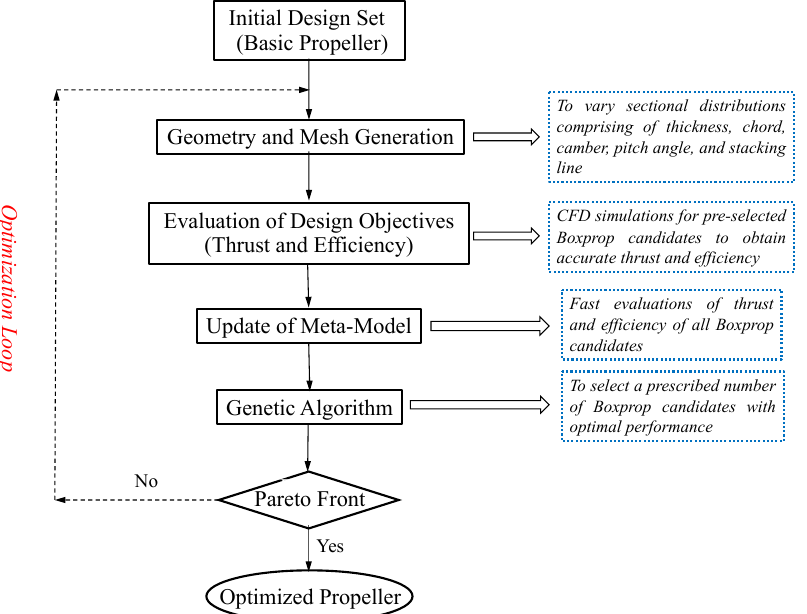
Figure 2. The flow chart of the optimization platform